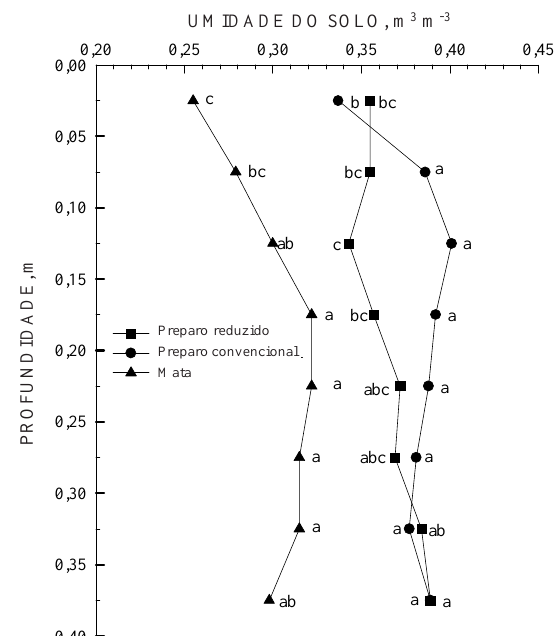
Figura 4. Umidade volumétrica do solo no sistema de preparo reduzido, preparo convencional e mata, na profundidade de 0–0,40 m (janeiro de 1999). Letras diferentes indicam diferença estatística entre as profundidades em cada sistema de uso. (Duncan, 5 %).